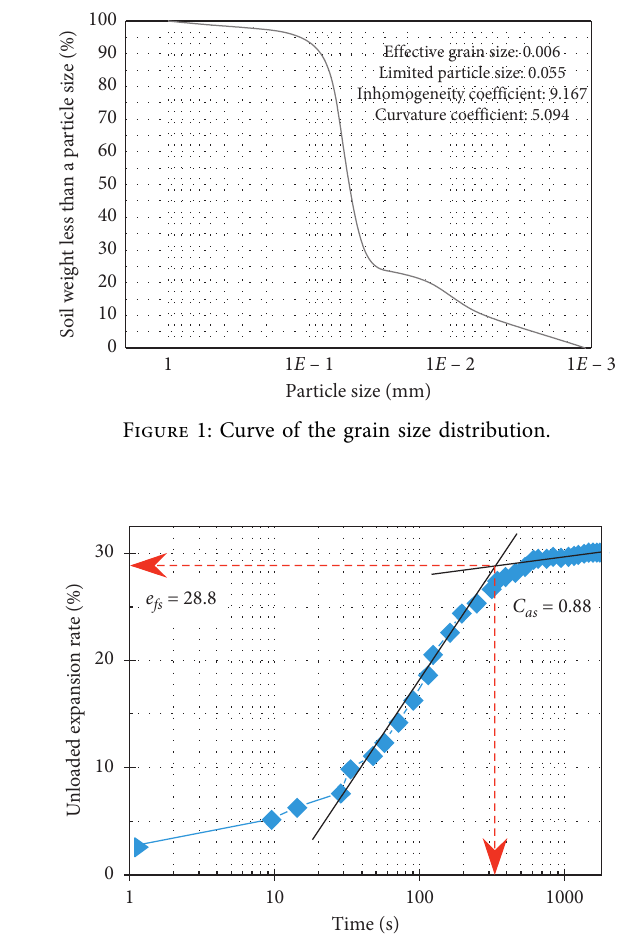
Figure 2: Curve of Expansion rate and time without load.